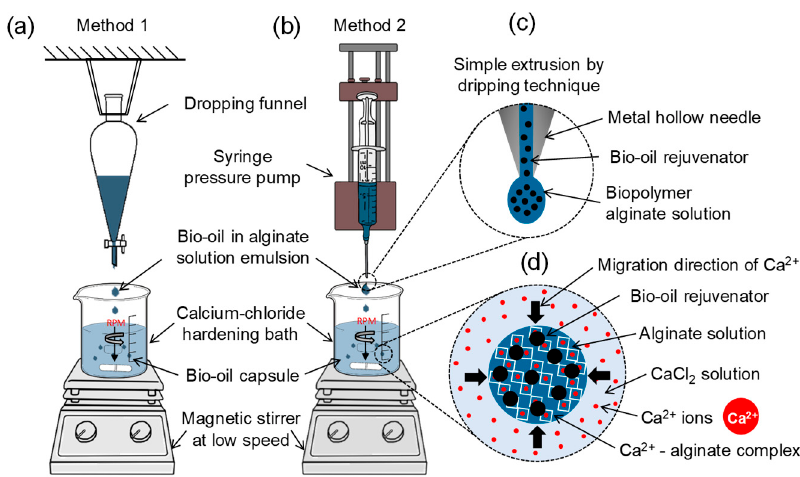
Figure 2. Preparation of the bio-based capsules containing bio-oil (BO). ( a ) Set-up of the dropping funnel method (M1); ( b ) set-up of the microfluidic pressure pump method (M2); ( c ) detail of BO